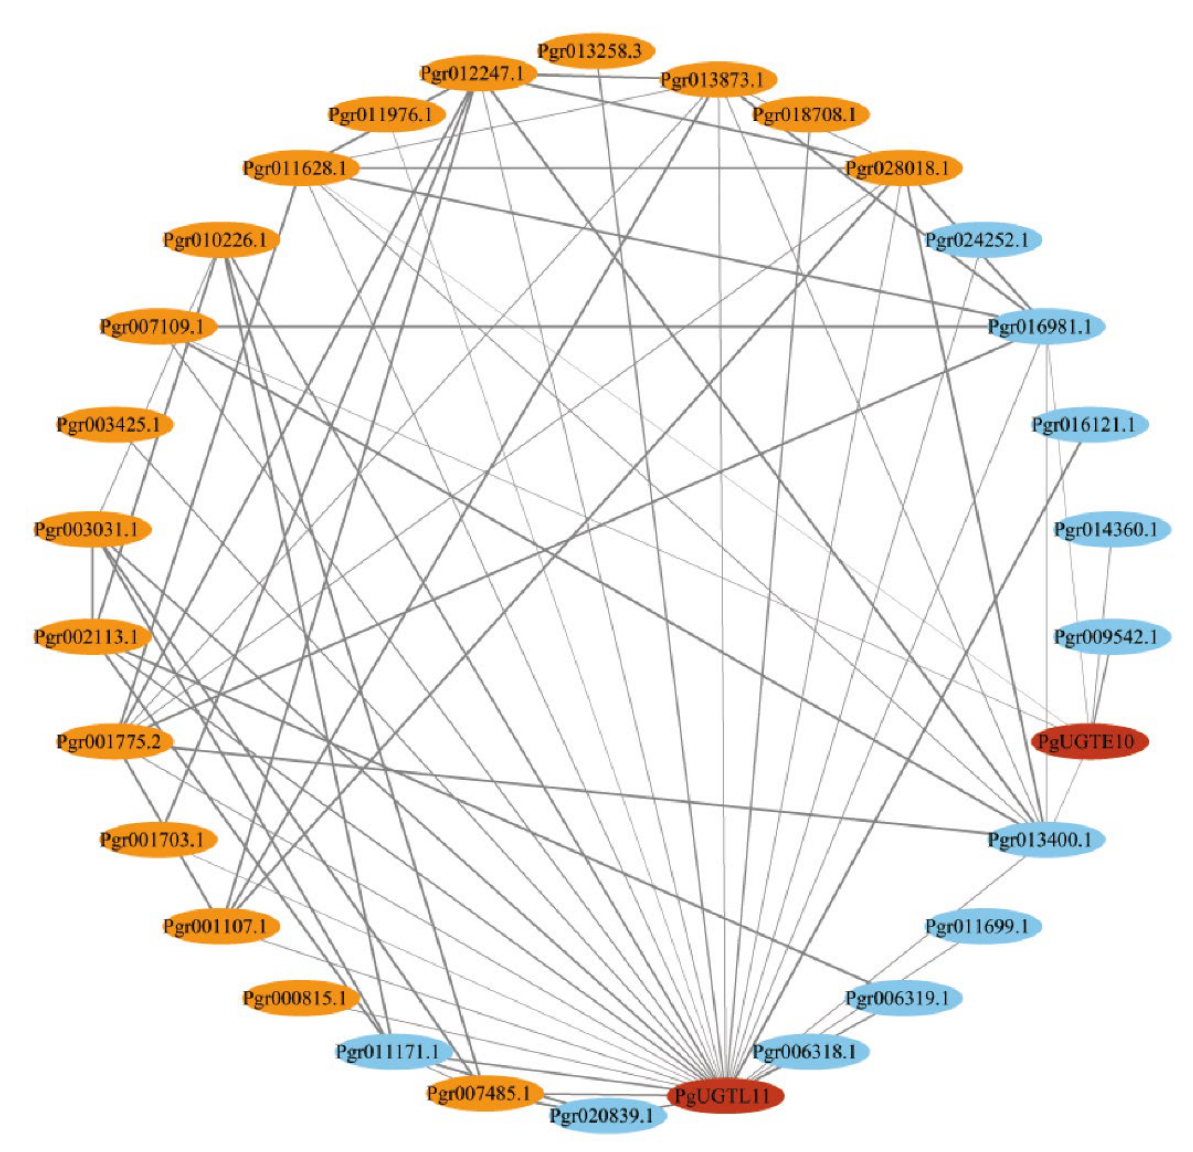
Figure 7. Co-expression network of candidate PgUGT s and genes involved in phenylpropanoid biosynthesis and hormone signaling pathways. The red nodes represent the PgUGT s, orange nodes represent genes involved in the hormone signaling pathway, and blue nodes represent genes involved in the phenylpropanoid biosynthesis pathway. The thickness of lines represents Pearson’s correlation coefficients.